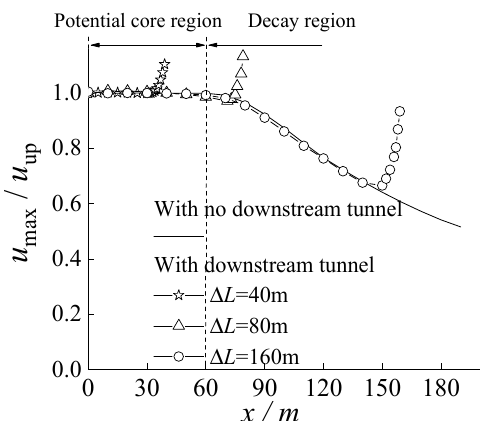
Figure 4. Distribution of u max in the symmetric plane of upstream exit jet for different values of ∆ L .